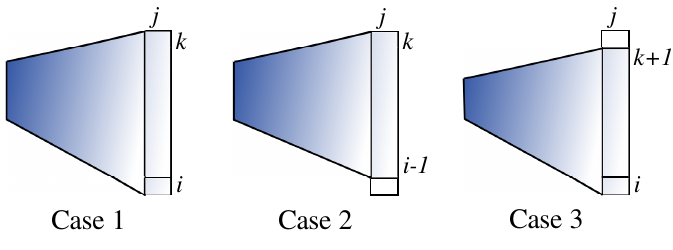
Figure 7. Three cases for